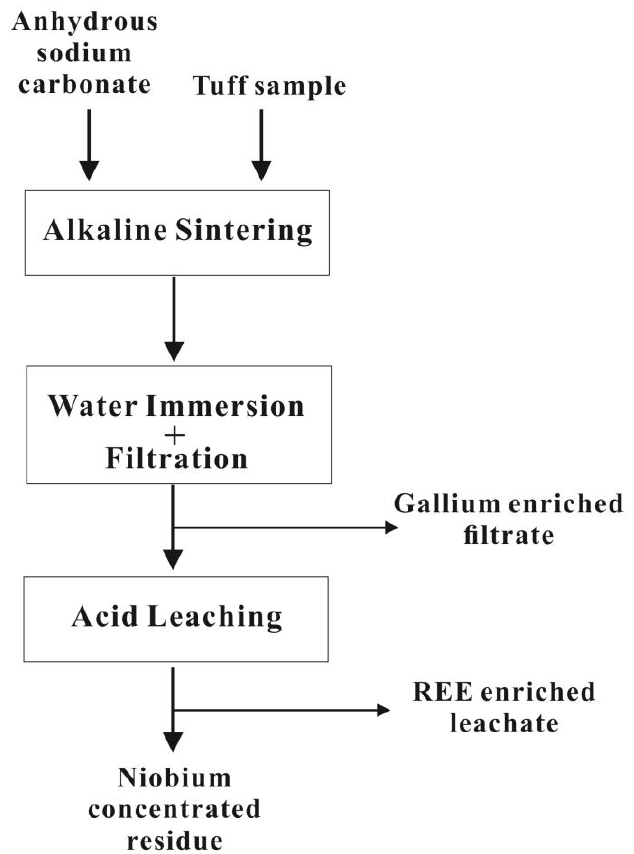
Figure 1. The schematic diagram of the alkaline sintering-water immersion-acid leaching process.